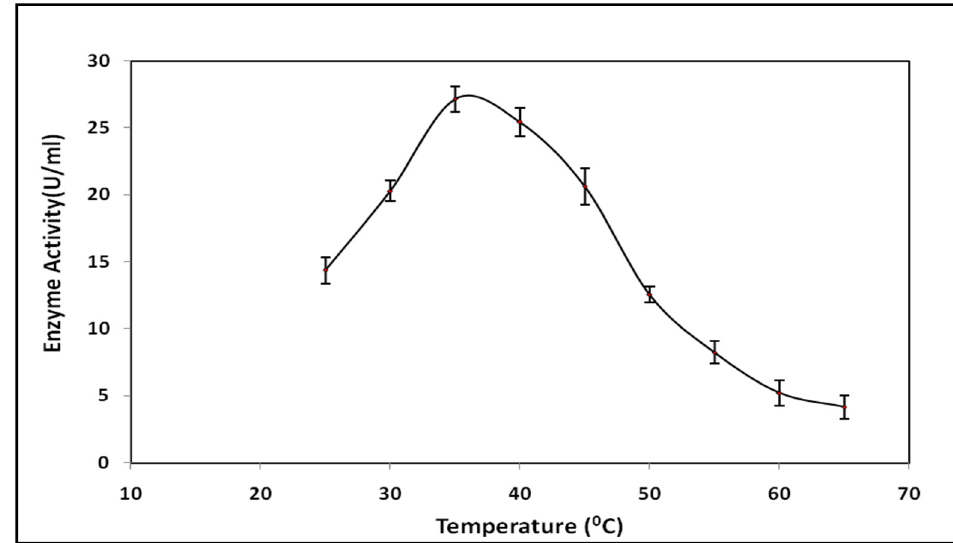
Figure 6. Effect of temperature on lipase activity.